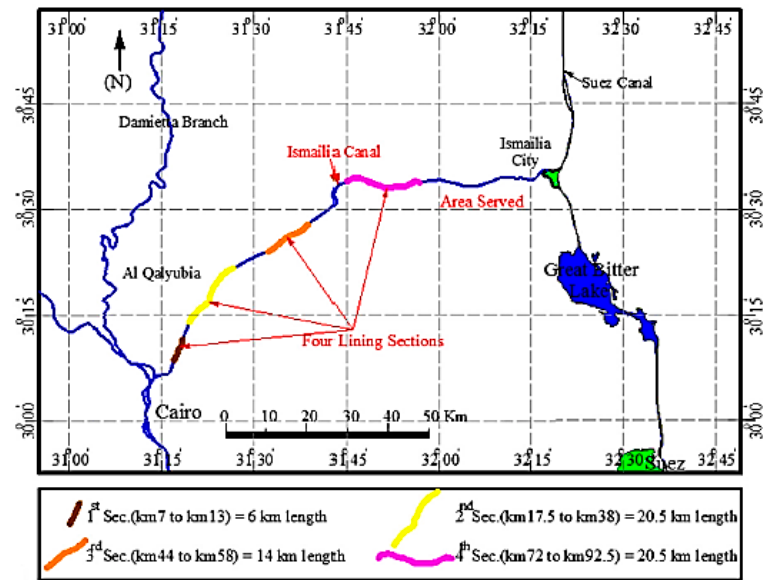
Figure 13. Ismailia Canal from its inlet at Cairo until it reaches the Ismailia governorate showing the four lining sections and their length [52].